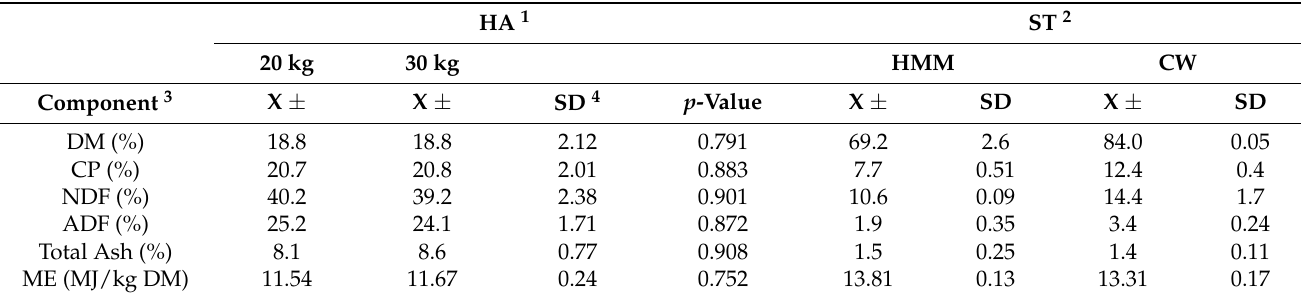
Table 1. Nutritional composition of pasture (>4 cm, n = 9) and supplements ( n = 5) offered throughout the study. Values are mean ± SD.